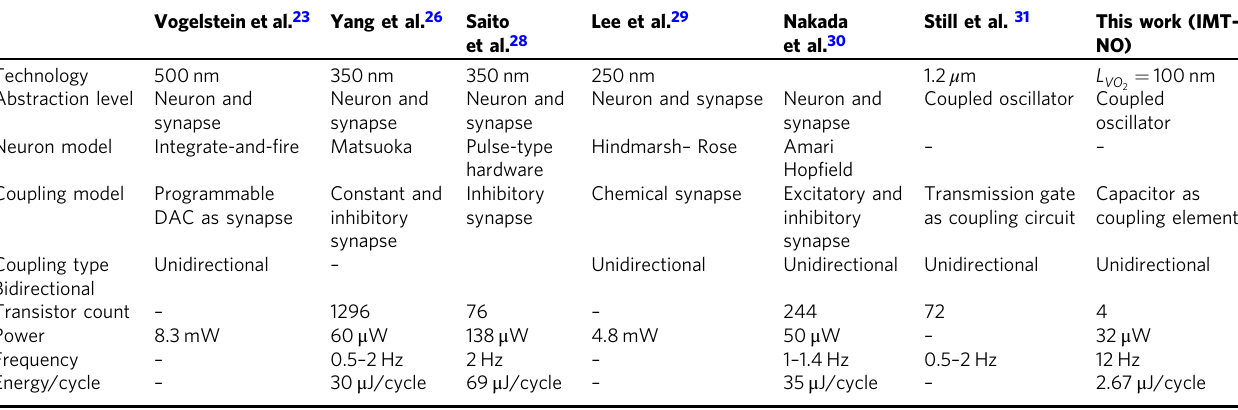
Table 1 Comparison of IMT oscillator-based CPG with various CMOS ASIC implementations highlighting an advantage in terms of power and circuit complexity (transistor